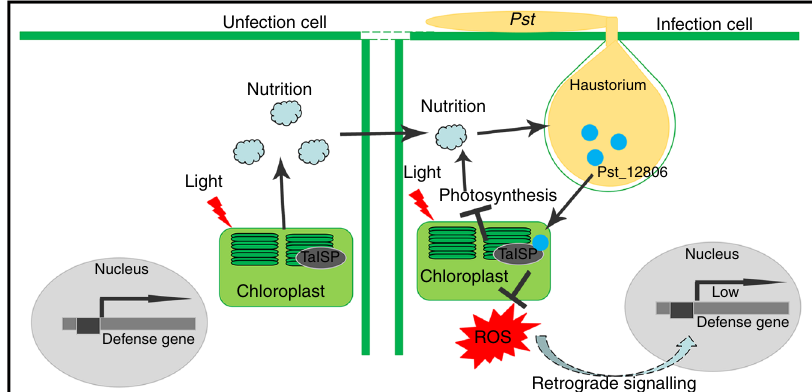
Fig. 8 Working model of the function of Pst_12806 during Pst – wheat interactions. In infected plant cells, the effector Pst_12806 is secreted from haustoria and translocated into chloroplasts, where it interacts with TaISP. Binding of Pst_12806 with TaISP interferes with the function of this protein in the electron transport chain and results in a decrease in the plant electron transport rate and attenuation of ROS accumulation, which in turn inhibits the expression of defense-related genes. In neighboring uninfected cells lacking Pst_12806, TaISP functions normally in photosynthesis, and synthesized carbohydrates may be transferred into the infected wheat